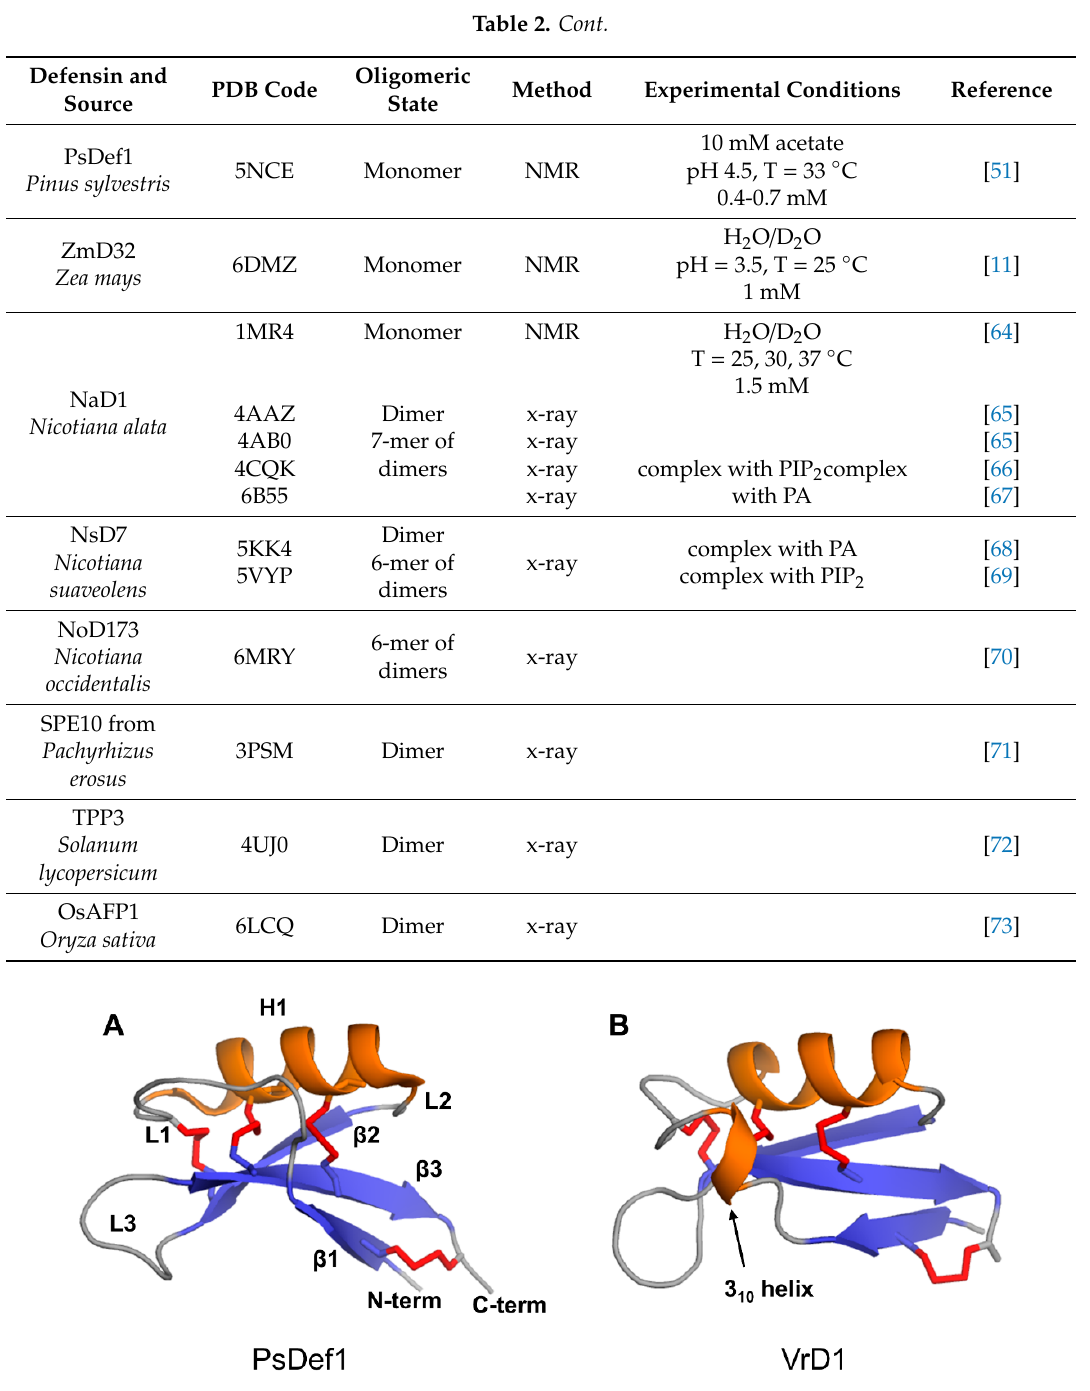
Figure 3. Three-dimensional structures of two plant defensin monomers. Structures of ( A ) PsDef1 (PDB code 5NCE) [51] and ( B ) VrD1 (PCB code 1TI5) [52] are shown in cartoon representations. Disulfide bonds are shown using red sticks. Letters indicate secondary structure elements on the structure of PsDef1 as follows: loops L1-L3, beta-strands β 1- β 3, alpha-helix H1. All plant defensins adopt a common disulfide-supported CS αβ fold.